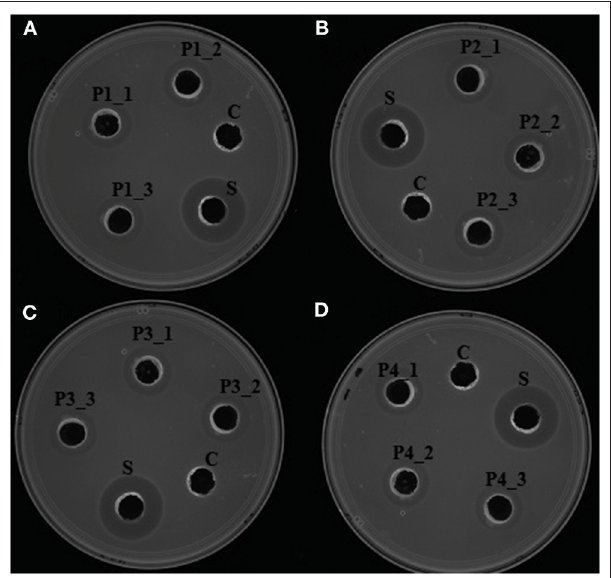
FIGURE 3 | In vitro antimicrobial activity assay of recombinant antilisterial proteins. Each crude recombinant protein was obtained from three different cultures and assayed in triplicates. (i) (A) P1_1, P1_2, and P1_3, (B) P2_1, P2_2, P2_3, (C) P3_1, P3_2, P3_3, and (D) P4_1, P4_2, P4_3 using agar well diffusion assay. C: crude protein of untransformed E. coli T7 Express LysY/Iq (New England BioLabs, Inc). S: cell-free culture supernatant of P. polymyxa Kp10. Inhibition zones were obtained in all of the recombinant proteins, thus confirming their antilisterial activity.